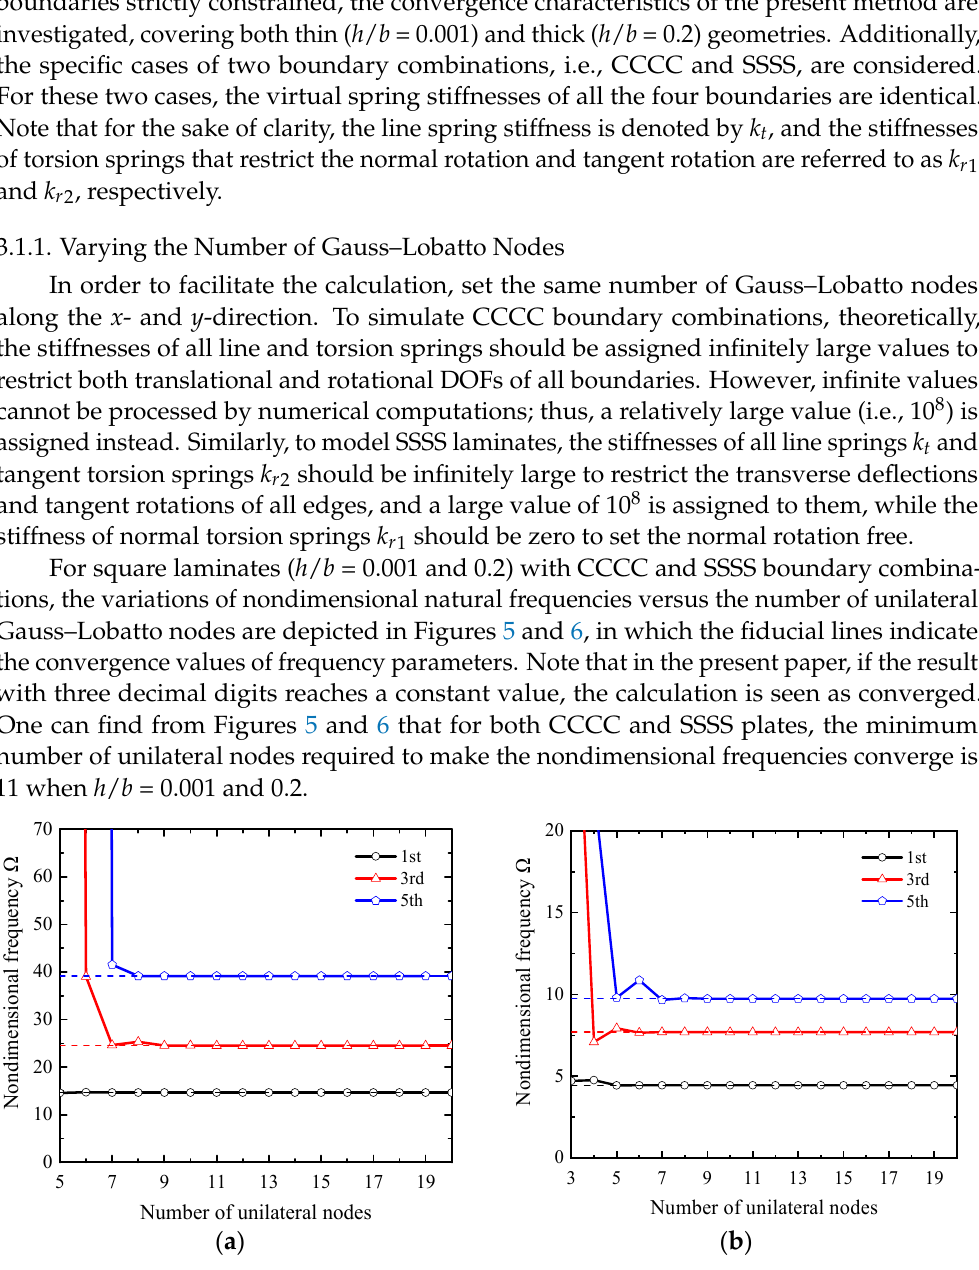
Figure 5. Variations of nondimensional frequencies Ω for CCCC laminates (0°, 90°, 0°) versus the number of nodes: ( a ) h/b = 0.001, k t = k r 1 = k r 2 = 10 8 ; ( b ) h/b = 0.2, k t = k r 1 = k r 2 = 10 8 .